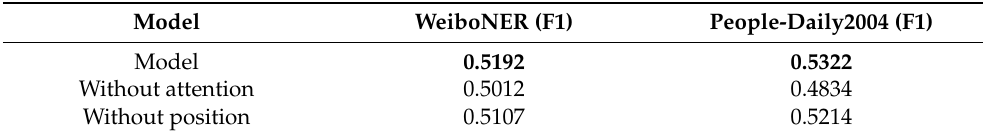
Table 5. Ablation experients.